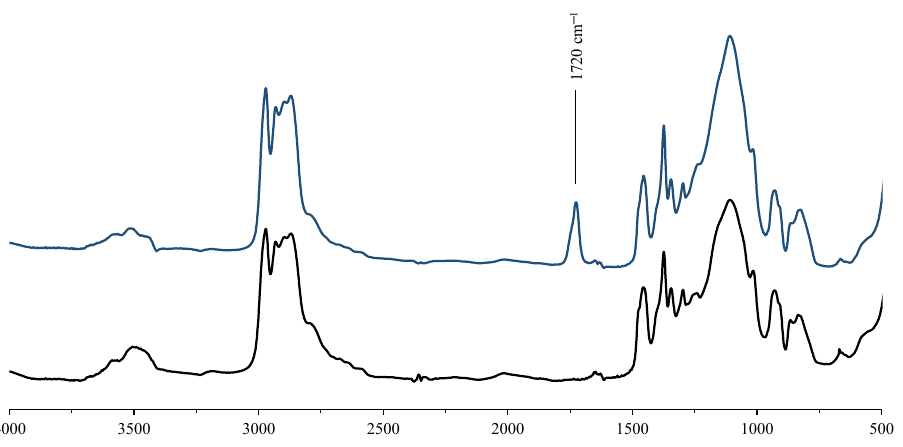
Figure 5. FT-IR spectra of STF2700 before (black line) and after (dark blue line) aging. PPG2700 and PPG425 were analyzed after exposure to UV radiation, using 1 H NMR and 13 C NMR spectroscopies to identify the degradation products.